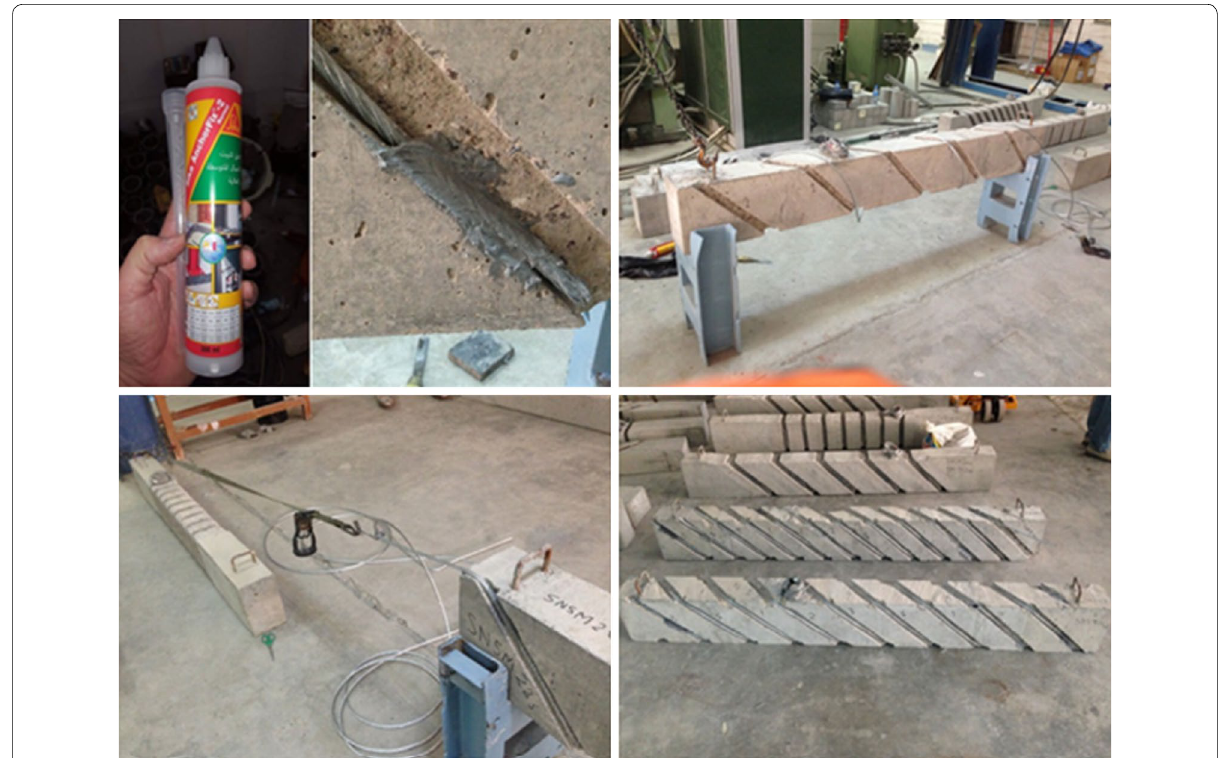
Fig. 4 Continuous spiral NSN steel wire rope